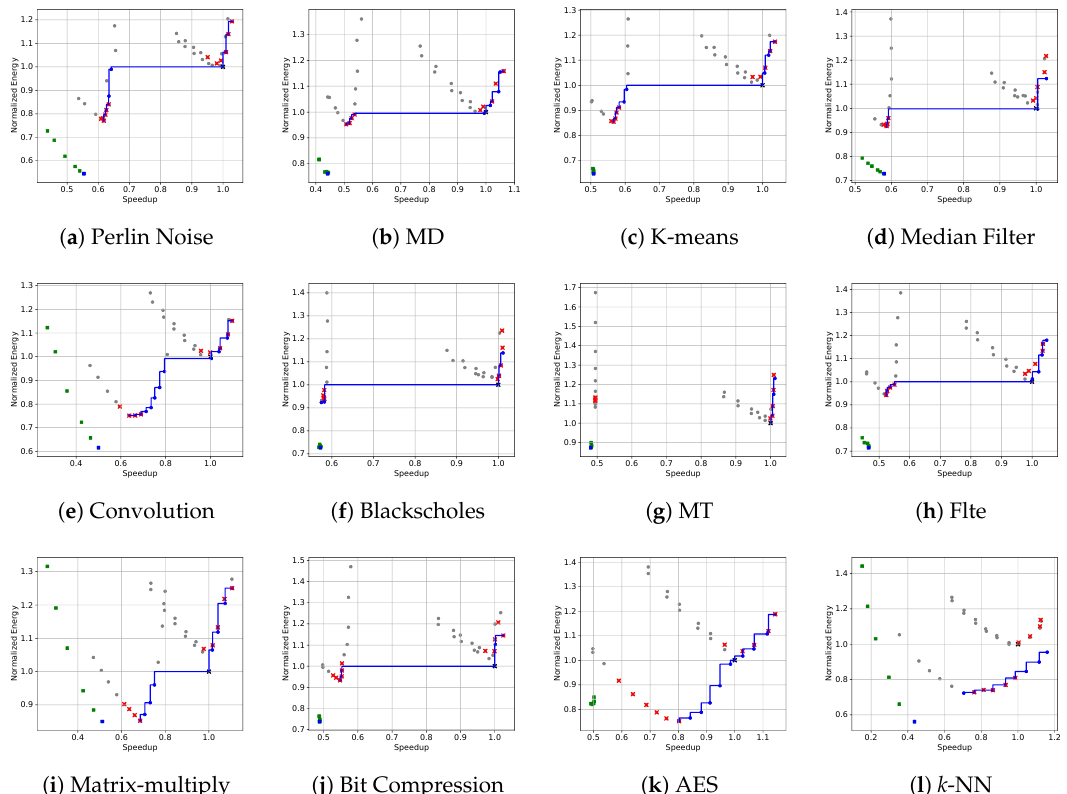
Figure 13. Accuracy of the predicted Pareto front. Measured solutions are shown for all configurations, while the other data points are based only on the highest frequency configurations. Bottom (energy)- right (speedup) is better. Table 2. Evaluation of predicted Pareto fronts.